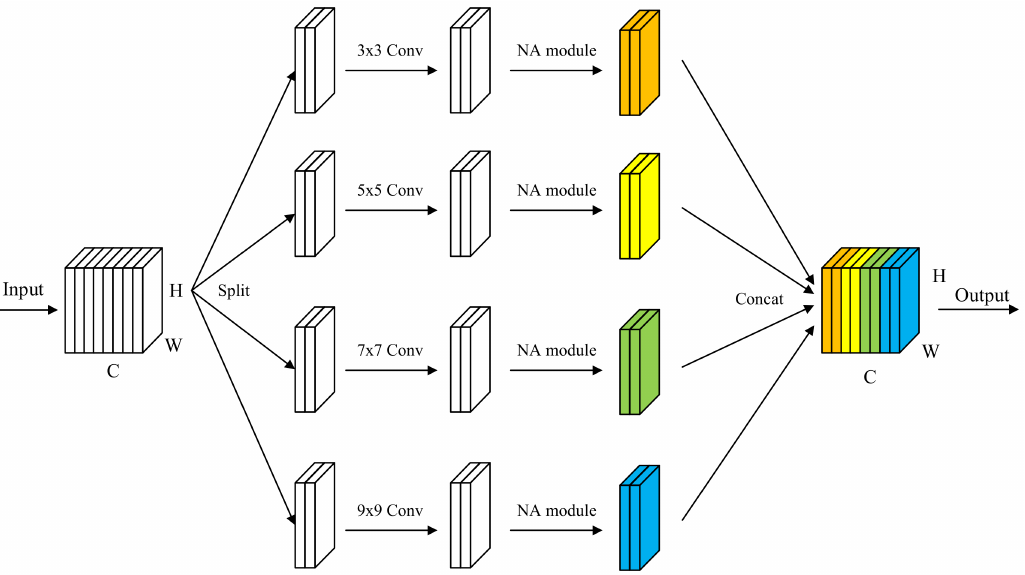
Figure 4. Pipeline of MSNA module. The white cube represents the unweighted feature maps, and the colored cubes represent the weighted feature maps. Different colors represent weighted feature maps with different